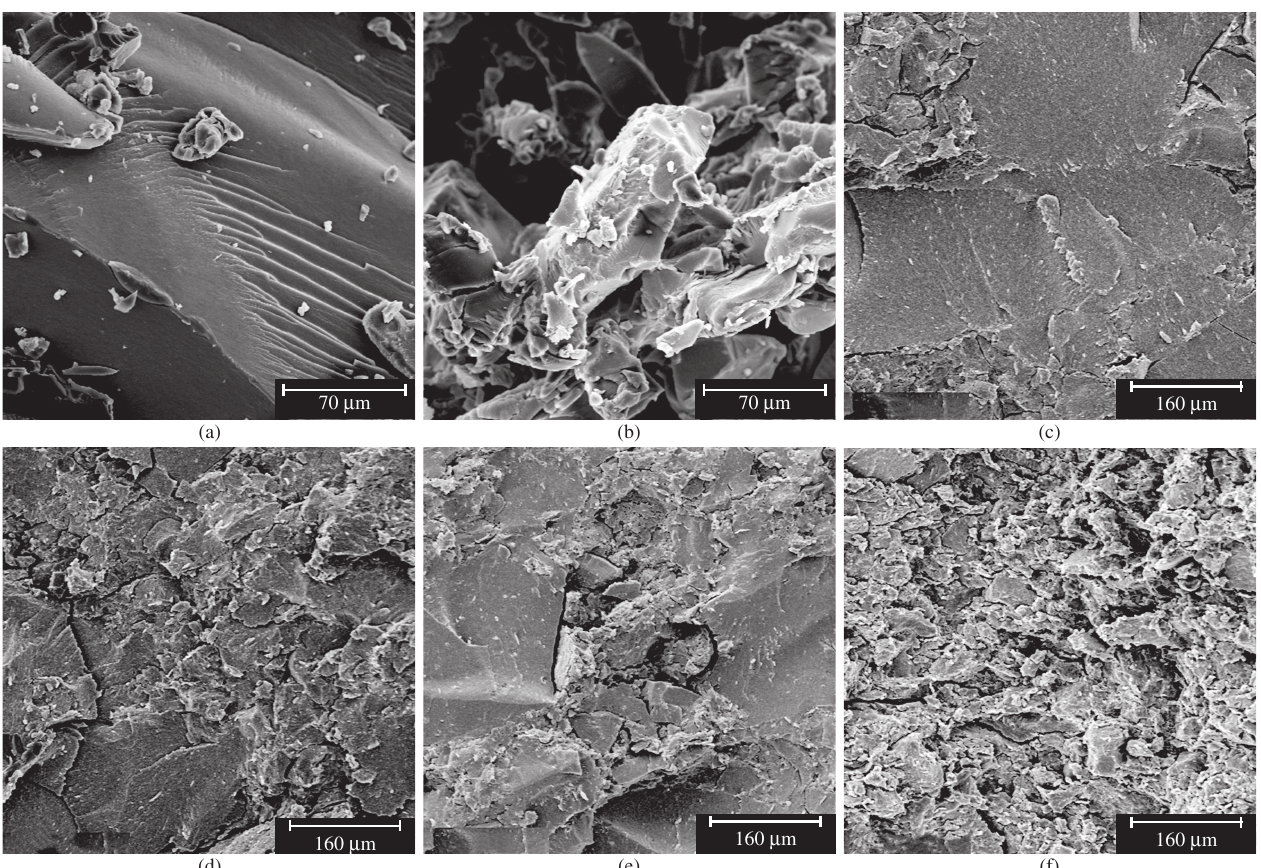
Figure 4. SEM micrographs of a, b) PAni-DBSA; c) PAni-Kaolinite 10%; d) 20%; e) PAni-Montmorillonite 10%; and f)